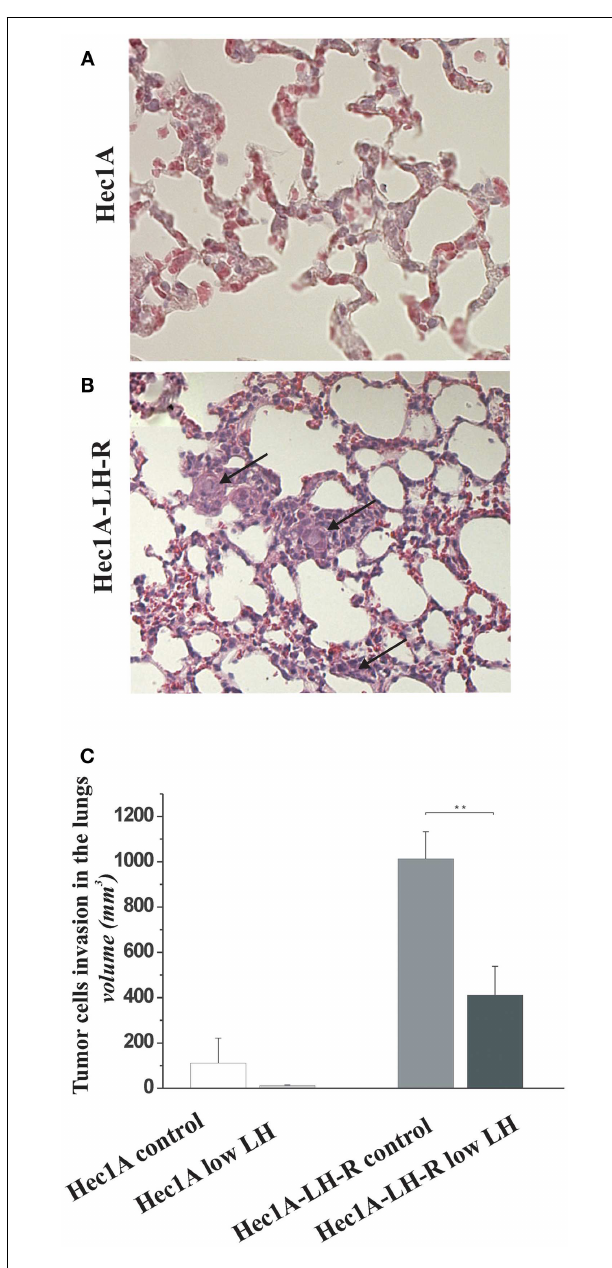
FIGURE 3 | Effects of LH-R over-expression and LH on distant metastases in the orthotopic xenograft model of endometrial cancer . (A,B) Hematoxylin and eosin (H&E) sections of lung metastases from mice orthotopically engrafted Hec1A and from mice orthotopically engrafted Hec1A-LH-R.Tumor cells (see arrows) are present in the lung parenchyma and inside vessels (40 × magnification). (C) Morphometric analysis of tumor cells invasion in the lungs. Histograms represent the mean of the area of invasion ± SEM (error bars). Mann–Whitney test has been performed ( p = 0.0043). Asterisk indicate statistical significance; p <